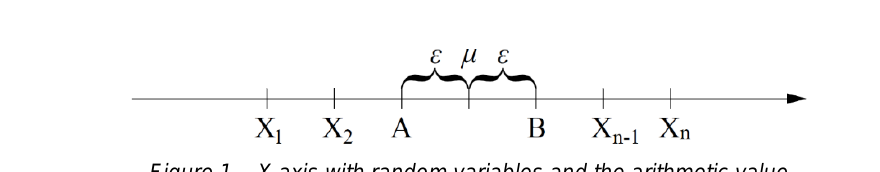
Figure 1 – X axis with random variables and the arithmetic